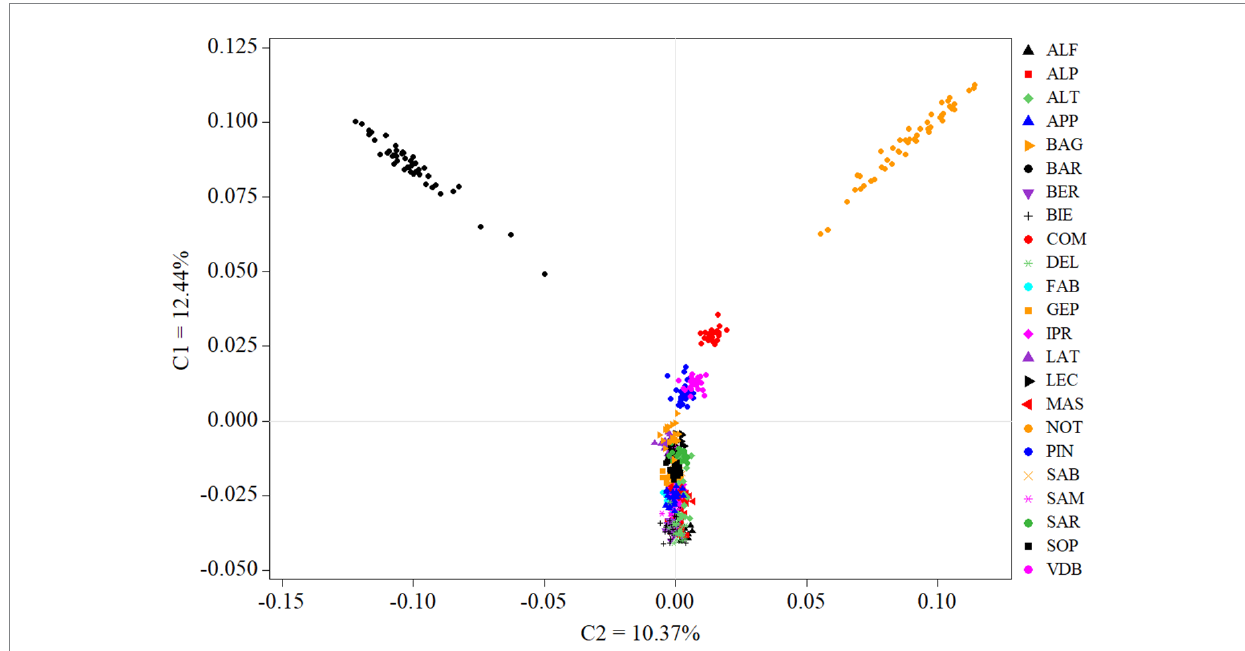
FIGURE 2 Multidimensional scaling analysis of ITAPOP dataset, comprehensive of 23 breeds in total. For full definition of the breeds, see Table